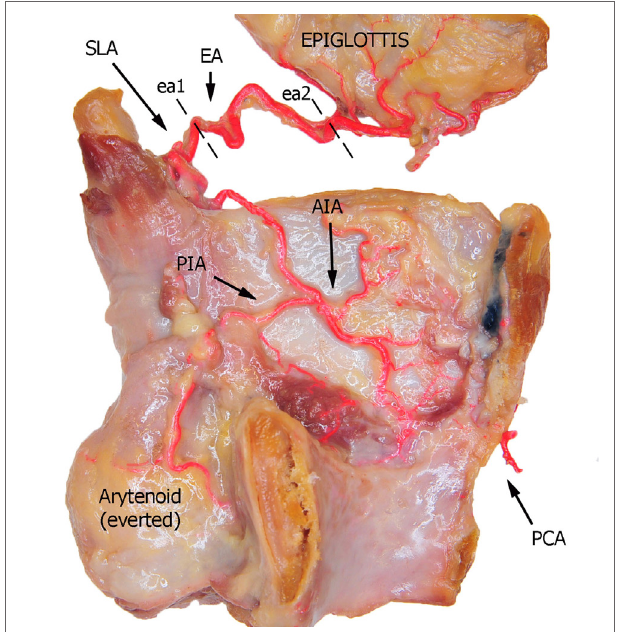
Figure 1 | Left fresh-frozen cadaver hemilarynx after midline section of the cricoid and thyroid cartilages, eversion of the ipsilateral arytenoid, and removal of the left aryepiglottic, false, true vocal folds, and paraglottic fat tissue, thus exposing the inner thyroid lamina. Bicomponent red silicone had been injected in the left common and subclavian arteries. Dotted lines ea1 and ea2 represent the landmark points used for measurements of the EA. Abbreviations: SLA, superior laryngeal artery; EA, epiglottic artery; AIA, antero-inferior artery; PIA, postero-inferior artery; PCA, paracommissural branch of the crico–thyroid